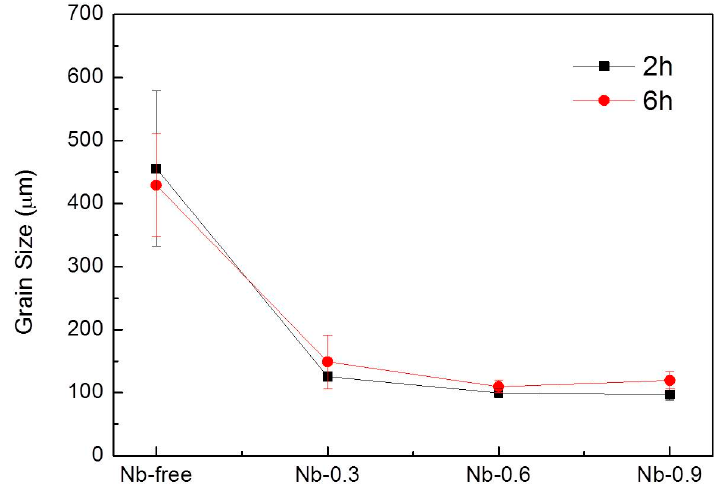
Figure 5. Average grain size as a function of Nb content in the 22Cr25NiWCuCo(Nb) steel specimens after heat treatment at 1200 °C for 2 and 6 h.